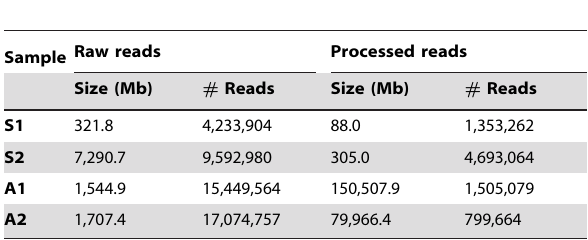
Table 2. Statistics of real NGS data as testing data for Parallel-